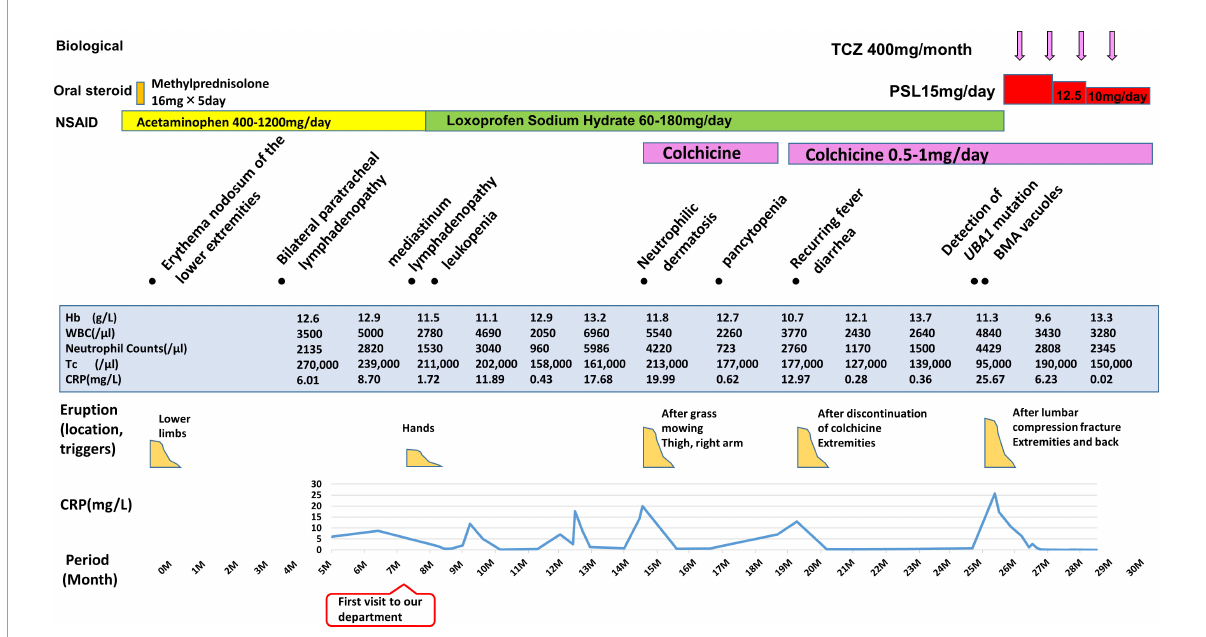
FIGURE2 Overview of patient’s disease course. TCZ, tocilizumab; PSL, prednisolone; NSAID, Non-Steroidal Anti-Inflammatory Drug; BMA, bone marrow aspirate; Hb, hemoglobin (normal range, 13.7–16.8 g/L); WBC, white blood cells (normal range, 3,300–8,600/ µ L); Tc, thrombocytes (normal range, 158,000–348,000/ µ L); CRP, C-reactive protein (normal < 3 mg/L).